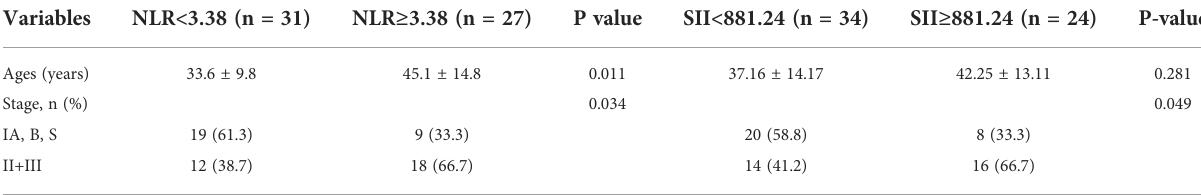
NLR, neutrophil/lymphocyte ratio; SII, systemic immune-in fl ammation